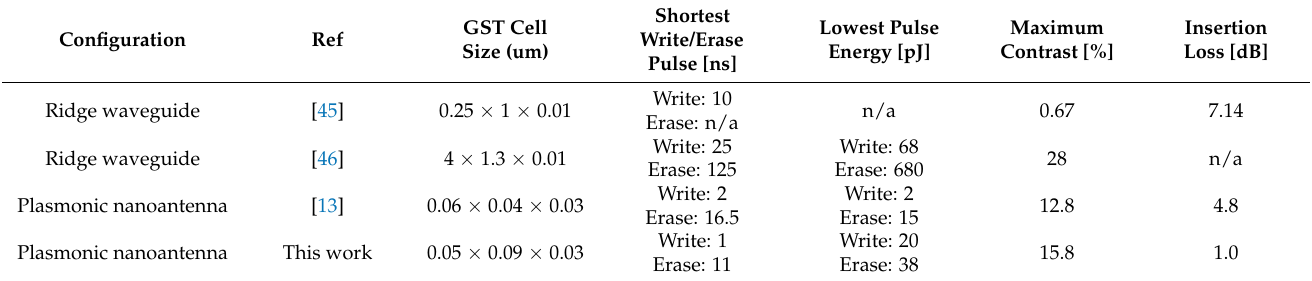
Figure 6. ( a ) The influence of different embedding depth on temperature difference TD and power con- sumption. ( b ) Thermal transient response of the PCM cell during amorphization under application of a 1.8 mW, 10 ns optical pulse. ( c ) Surface Instantaneous temperature distribution of the cross-sectional integrated nanoantenna devices for non-embedded structure. ( d ) Surface instantaneous electric field distribution of the cross-sectional integrated nanoantenna devices for none-embedded structure. Table 3. Comparison of pulse parameter and energy for crystallization and